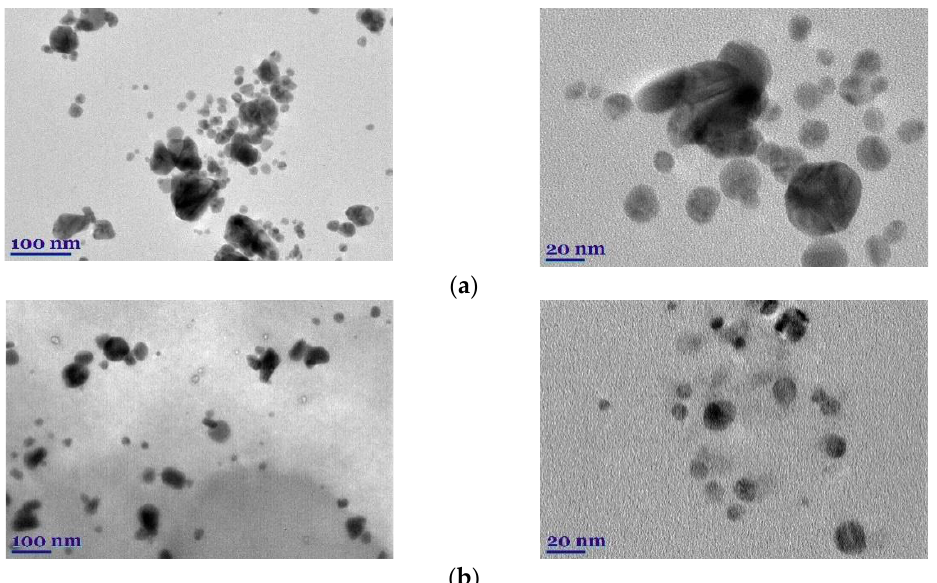
Figure 6. TEM images of biosynthesized CaO-AgNPs ( a ) and HyO-AgNPs ( b ).